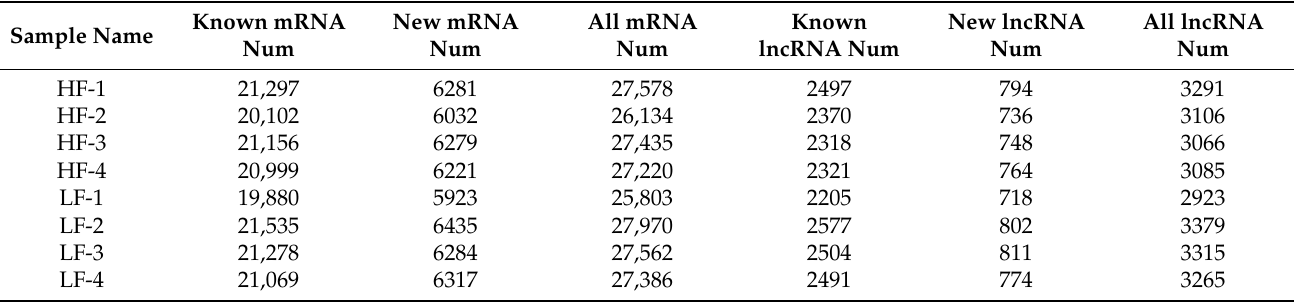
Table 5. Summary of transcript